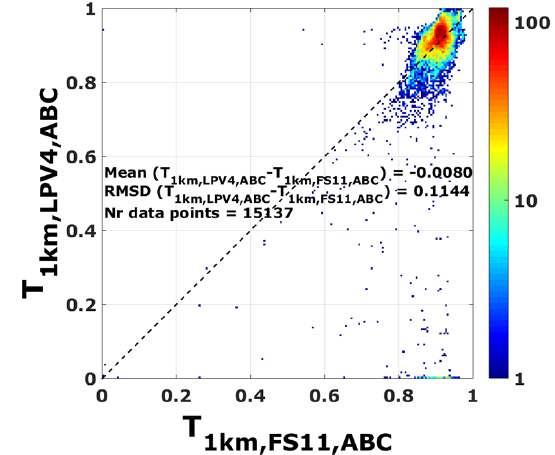
Figure 7. Absorption and broadband-corrected transmittance for 1km slant range measured by FS11 scatterometer and LPV4 trans- missometer. No sun photometer input in ABC procedure. Color dis- tribution displays the number of data points per grid point (logarith- mic color